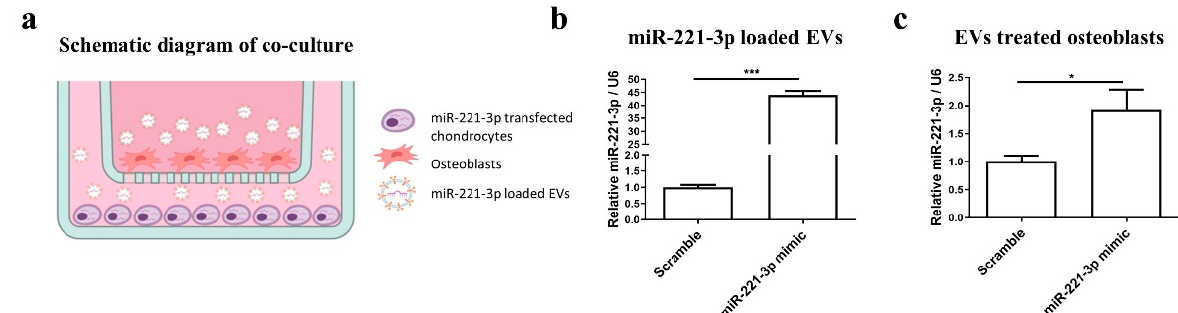
Figure 5. Chondrocyte signals through miR-221-3p can be transferred to osteoblasts via extracellular vesicles ( a ). Osteoblasts and chondrocytes were cocultured in a transwell system. miR-221-3p was overexpressed in EVs secreted by transfected chondrocytes ( b ). miR-221-3p in osteoblasts was significantly increased when cocultured with transfected chondrocytes ( c ). miRNA expression relative to U6. * p < 0.05 and *** p < 0.001 vs. corresponding control. This figure was partly created with BioRender.com (May 2021).